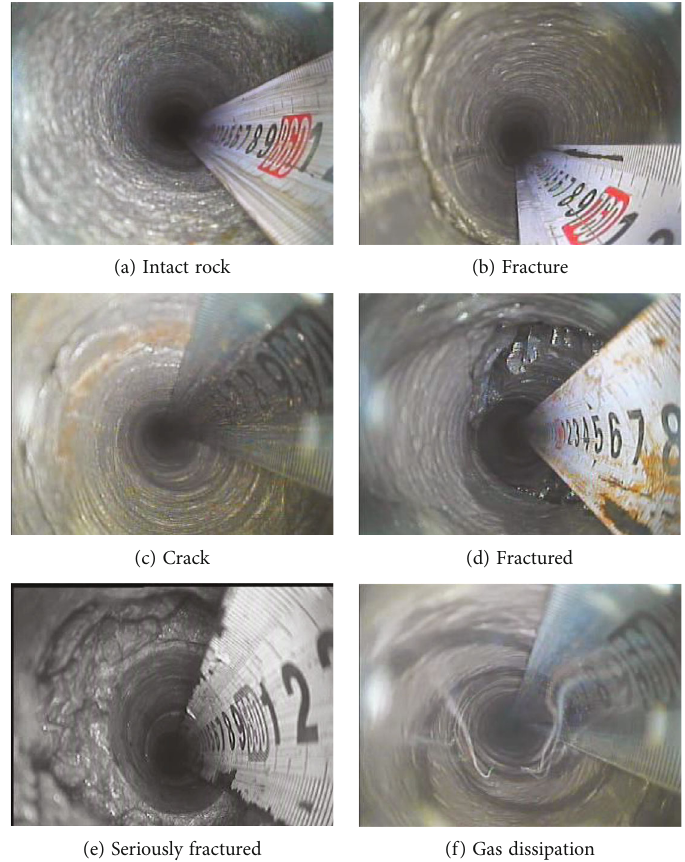
Figure 17: Peering video screenshots of drill